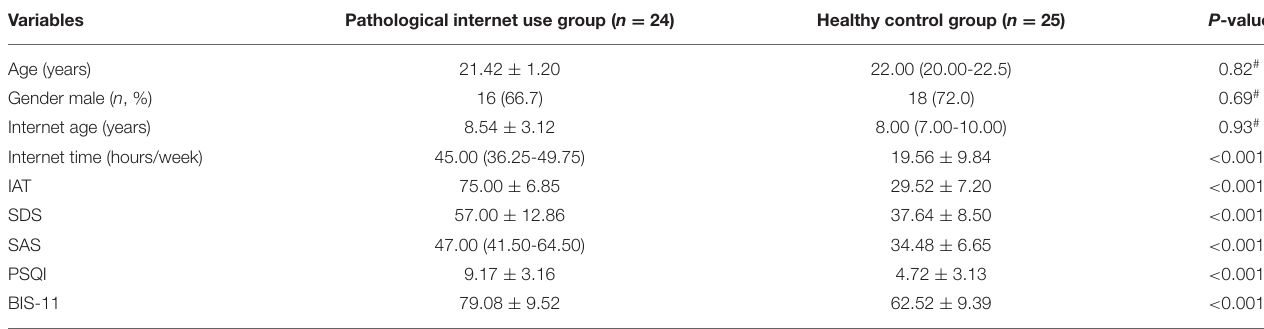
TABLE 1 | Demographics and clinical characteristics of pathological internet use and healthy control groups. Variables